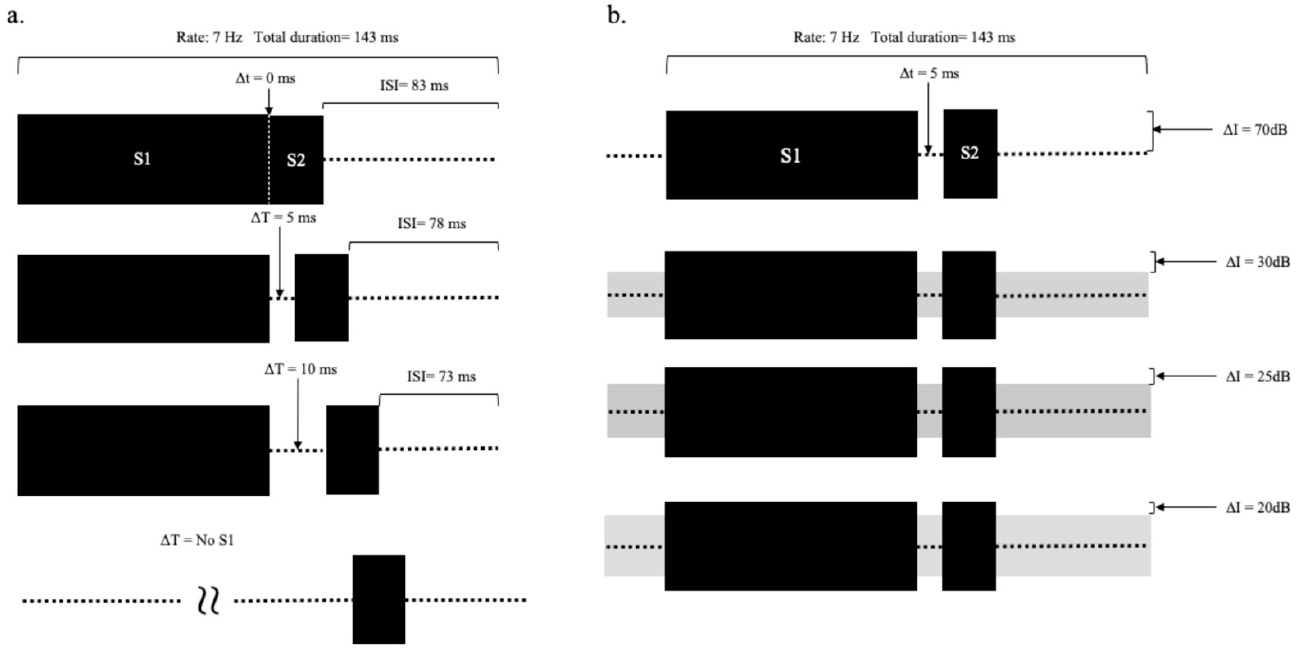
Figure 3. Diagrams of two tests. ( a ) Different durations of the silent gap ( ∆ t). ( b ) Different intensities of continuous background noise (gray blocks) ( ∆ I) (interstimulus interval (ISI) = 143 ms − (S1 + S2 + ∆